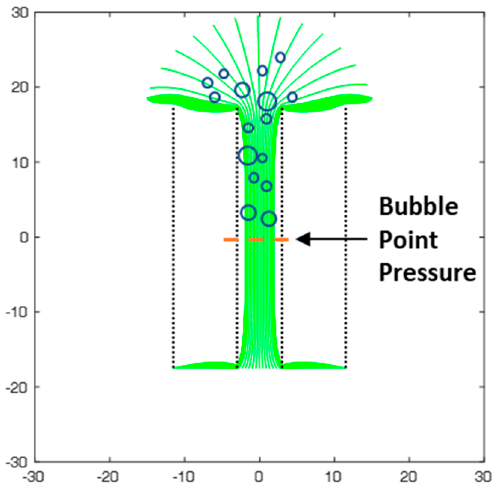
Figure 19. Dissolution of the gas molecules from the single oil phase occurring when the produced fluid moves up in the production tube and the pressure drops below bubble point at a certain depth. Length units are scaled in cm (both x-axis and y-axis).